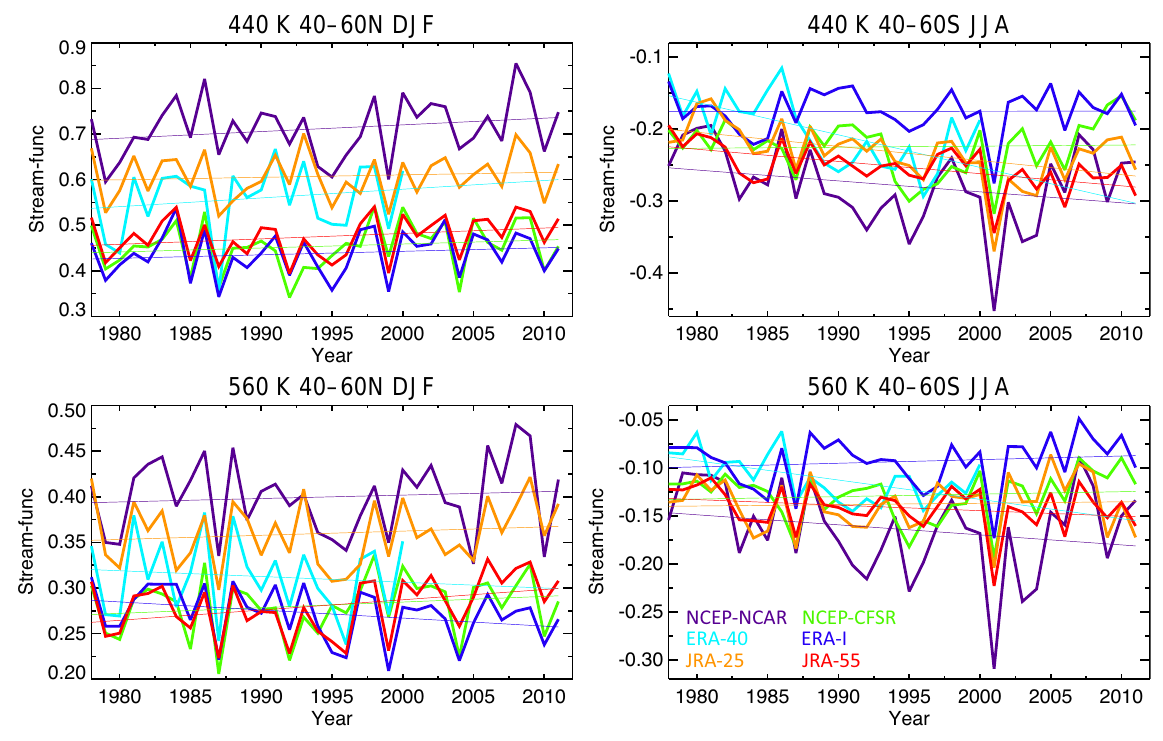
Figure 6. Same as Fig. 2 but for the mass stream function (in 10 10 kgs − 1